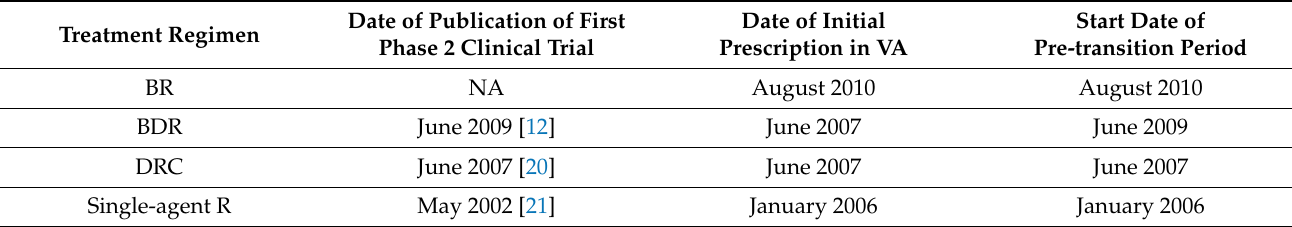
Table 3. Example milestones used to determine pre-transition start dates for ITS